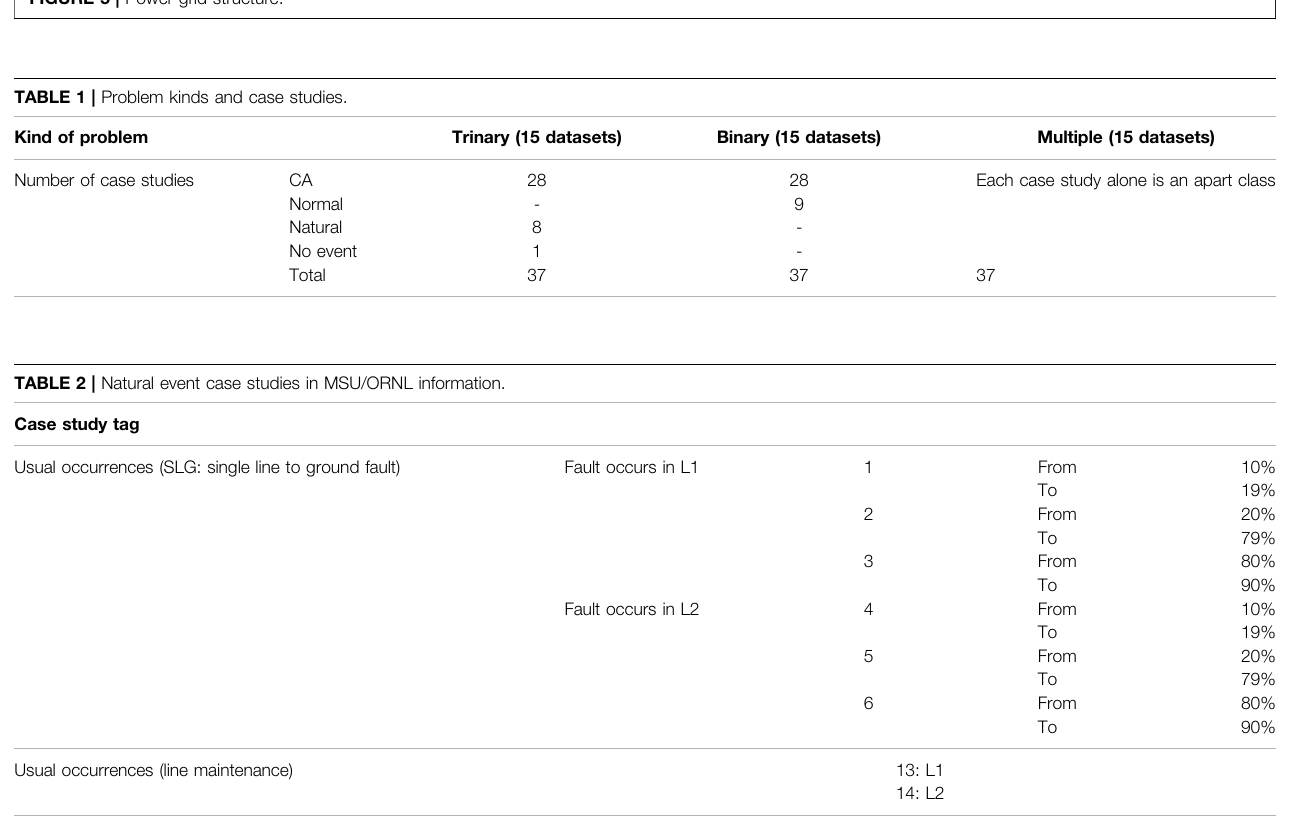
FIGURE 5 | Power grid structure.